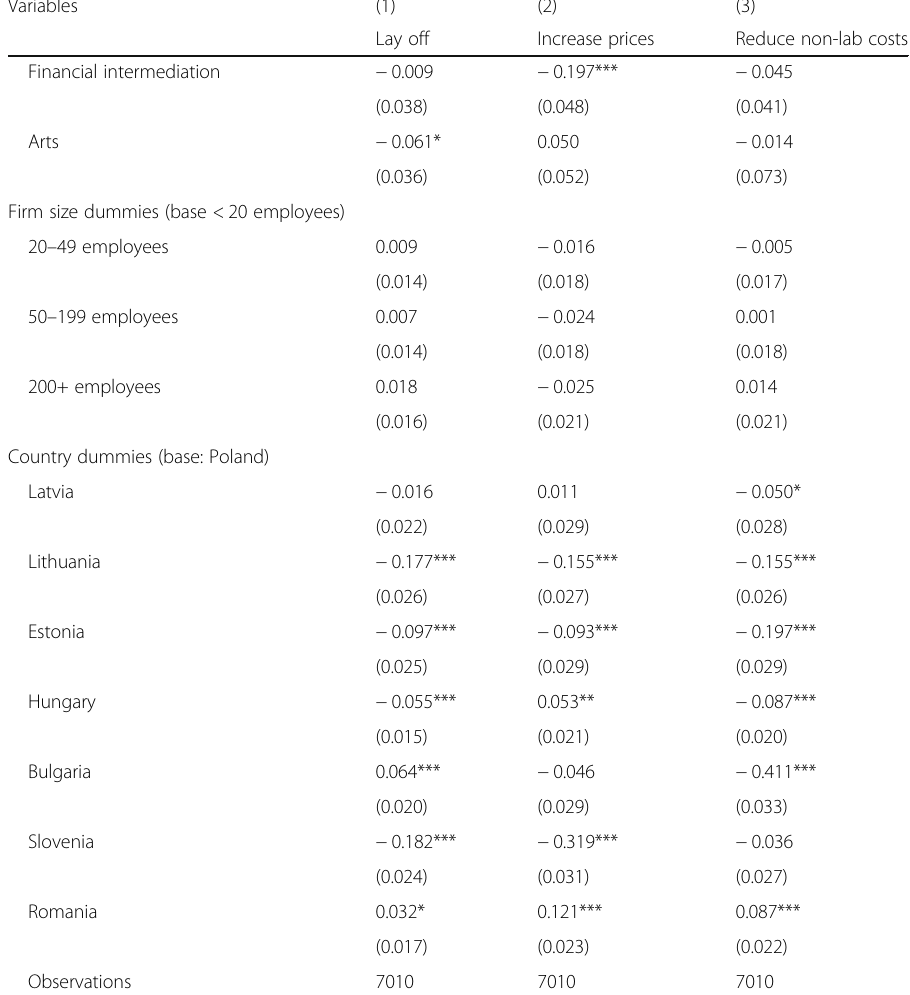
Table 13 Multivariate probit model of the relevance of adjustment channels, average marginal effects